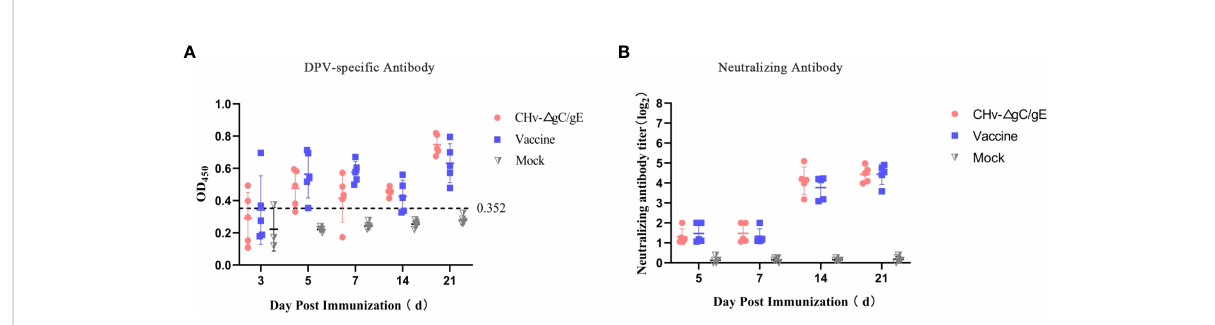
FIGURE 6 Production of CHv-speci fi c antibodies in virus-inoculated ducklings. (A) The UL55-speci fi c antibodies in the different groups at the indicated time points. The ELISA values for serum samples are given as OD450 and were deemed positive when OD 450 > 0.352. (B) Serum neutralizing antibodies (NAbs) against the CHv in the indicated groups at 21